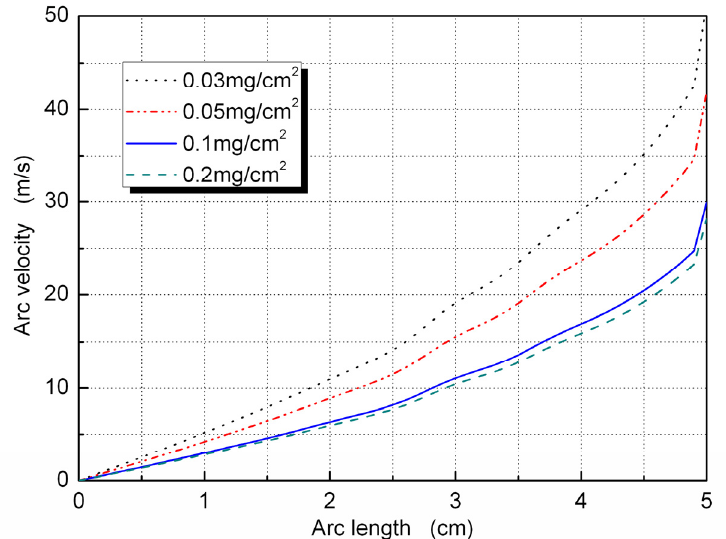
Figure 6. Variation of the calculated velocity with the arc